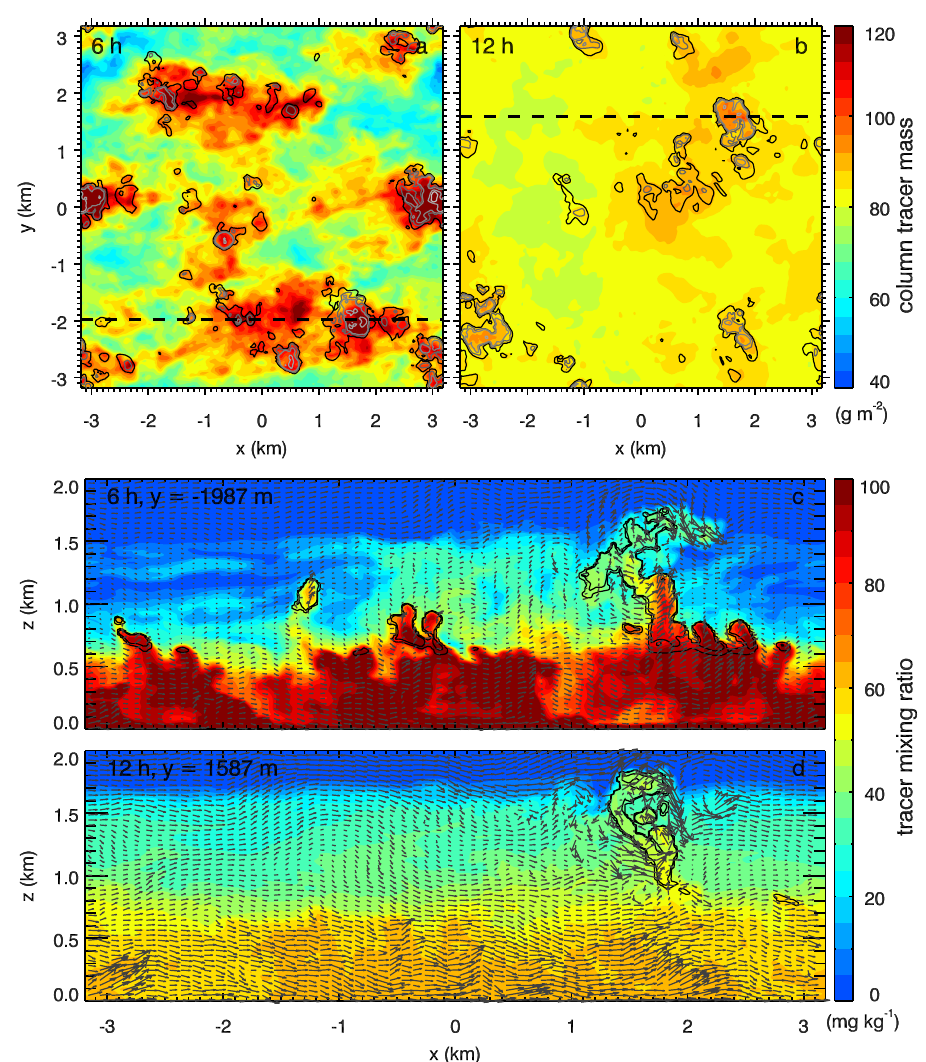
Fig. 3. Snapshots of column integral tracer mass (a, b) and two selected vertical cross sections (c, d) . In (a) and (b) , the contours from dark to light indicate liquid water path with increasing values of 10, 50, 100, 300 and 500gm − 2 . It is shown that cloudy columns usually have higher tracer mixing ratio than cloud-free columns. In (c) and (d) , the contours indicate liquid water mixing ratio with increasing values of 0.01, 0.1 and 1gkg − 1 , and the arrows indicate u-w wind